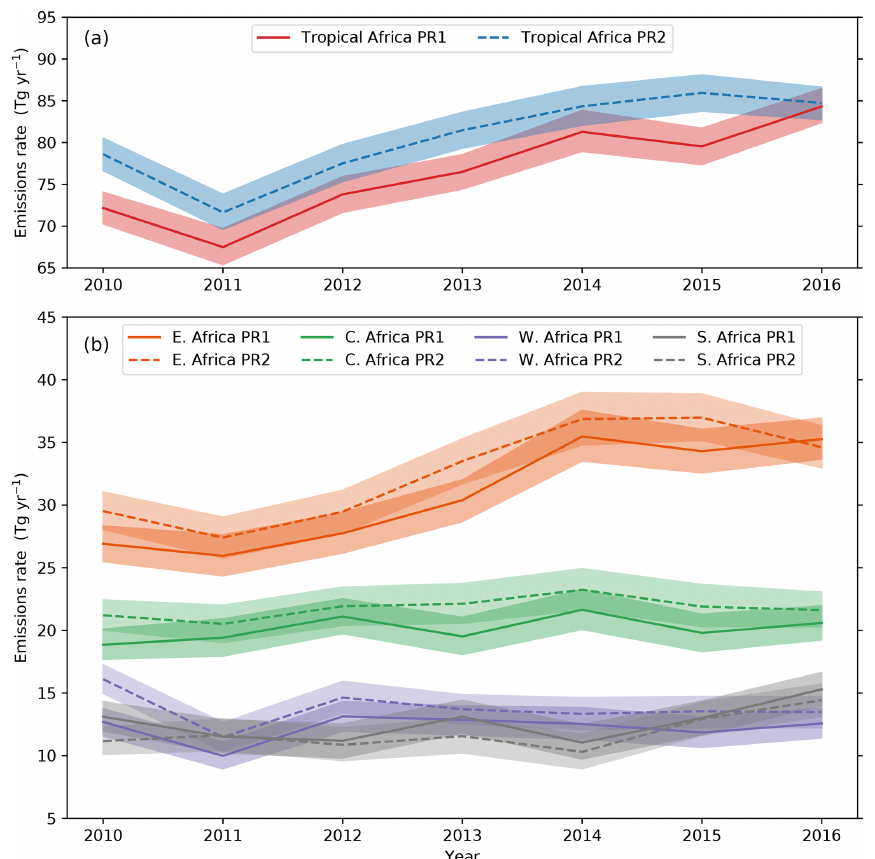
Figure 5. (a) Annual a posteriori emissions for tropical Africa. (b) Annual a posteriori emissions for East Africa (orange), Central Africa (green), West Africa (purple) and Southern Africa (grey). Solid lines represent the PR1 a posteriori mean; dashed lines indicate the PR2 a posteriori mean in each panel. Shading represents the 95% uncertainty range in both